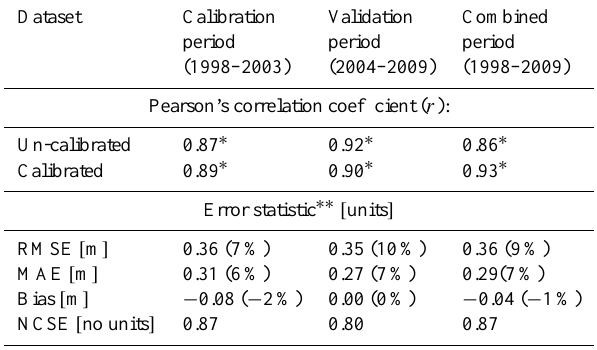
Table 3. Results of calibration and accuracy assessment of mod- elled lake water levels using satellite altimetry data.